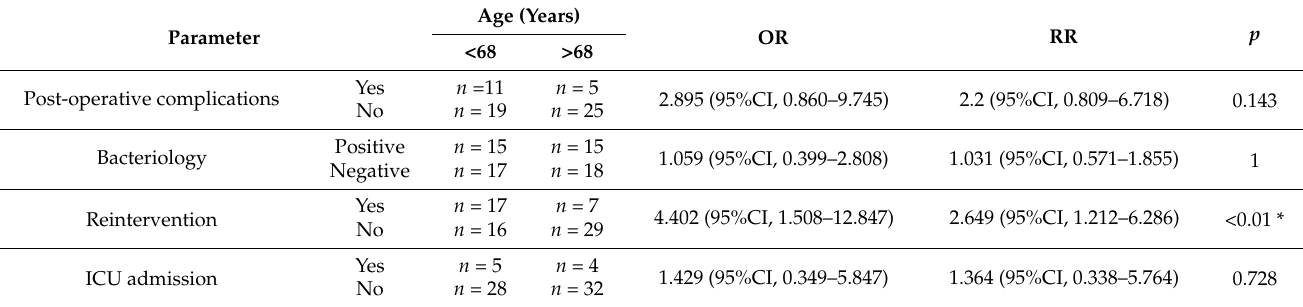
Table 4. Comparison of post-operative complications, bacteriology assay results, reintervention, and ICU admission between patients aged < 68 years and > 68 years.